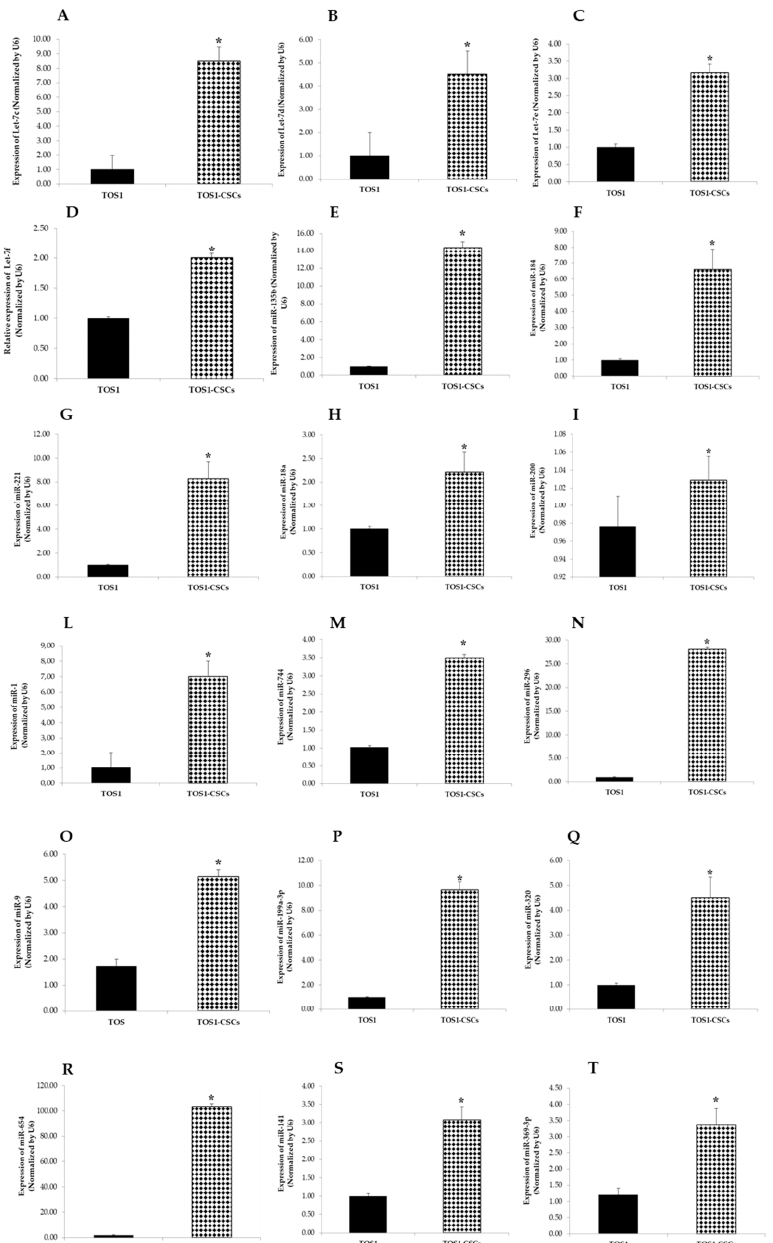
Figure 12. Expression levels of 18 miRNAs in TOS1-CSCs line. RT-qPCR analysis of expression of Let-7c ( A ), Let-7d ( B ), Let-7e ( C ), Let-7f ( D ), miR-135 ( E ), miR-184 ( F ), miR-221 ( G ), miR-18a ( H ), miR-200 ( I ), miR-1 ( L ), miR-744 ( M ), miR-296 ( N ), miR-9 ( O ), miR-199a-3p ( P ), miR-320 ( Q ), miR-654 ( R ), miR-141 ( S ), and miR-369-3p ( T ) in TOS1 and in TOS1-CSC cell lines. Data represent the mean with standard deviation ( n = 4); * p < 0.001 as compared to TOS1 cell line. On the contrary Let-7a, miR-25, miR-423-5p, miR-365, miR-500, and miR-365 were notably downregulated compared to the TOS1 cell line. Results obtained showed also that there is no difference in the expression levels of Let-7g in the TOS1-CSCs cell line compared to the TOS1 cell line (Figure